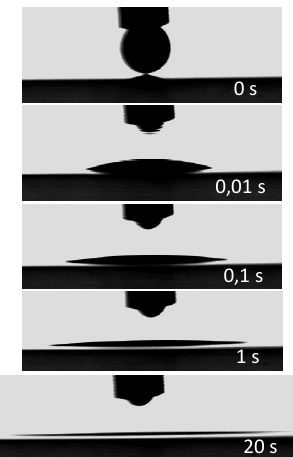
Fig. 4 - Spreading of a CuAg alloy saturated in Cu on monocrystalline Cu studied by the dispensed drop technique. The diameter of the droplet before wetting is 0.9mm [9].